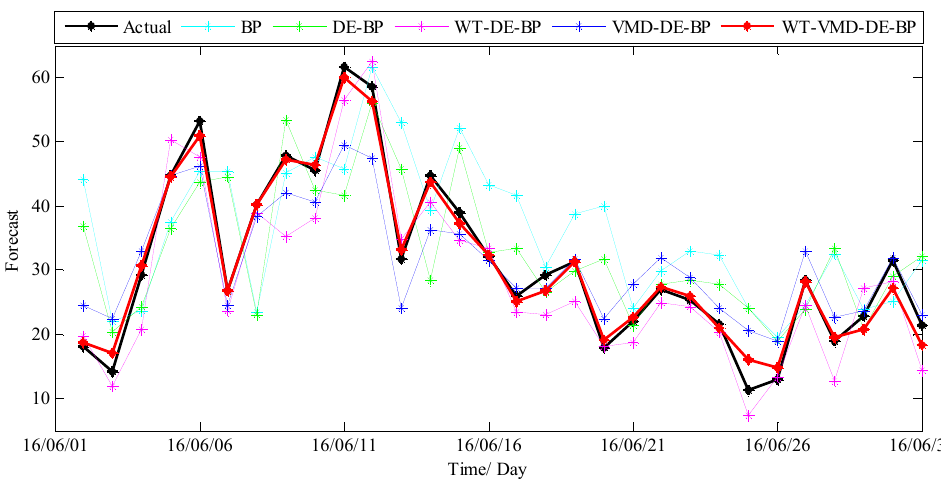
Figure 12. The ultimate forecast result of different models (Wuhan). Table 2. Comparison of prediction performances of different models